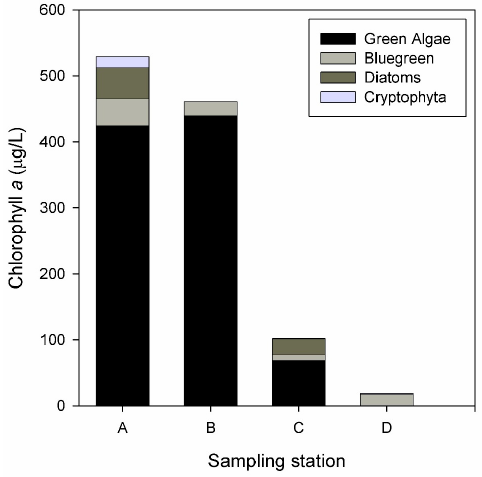
Figure 2. Longitudinal profile of total chlorophyll a and relative contribution of phytoplankton identifiable groups by fluorescence